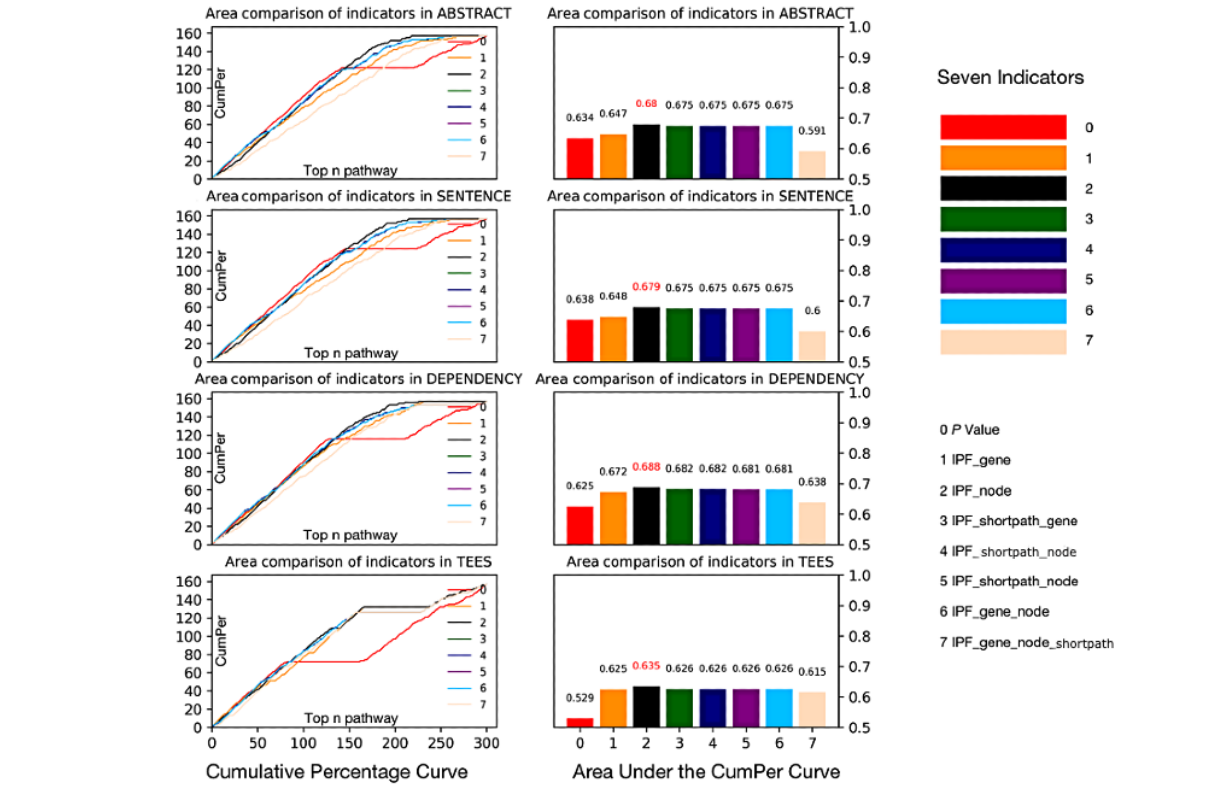
Figure 3. Comparison of the pathway-enrichment metrics based on the rapamycin-related gene set. CumPer: cumulative percentage; IPF: inverse pathway frequency; TEES: Turku Event Extraction System.